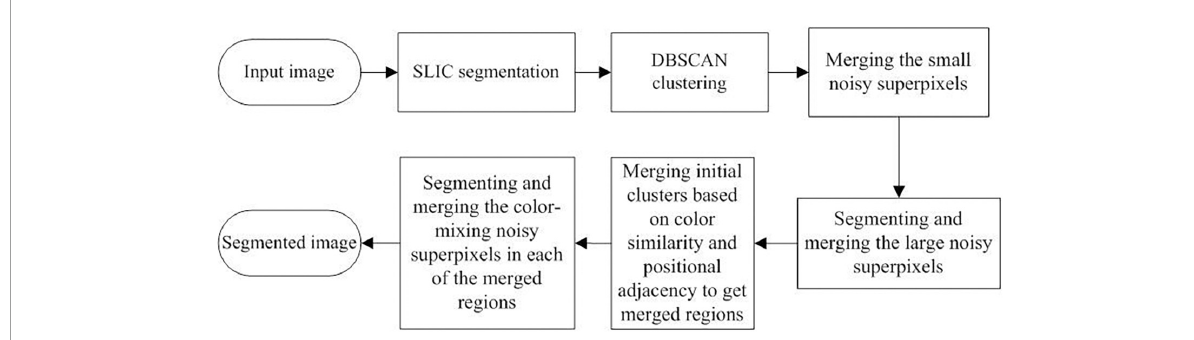
FIGURE1 Workflow of the proposed optimized method for ancient mural image segmenting.